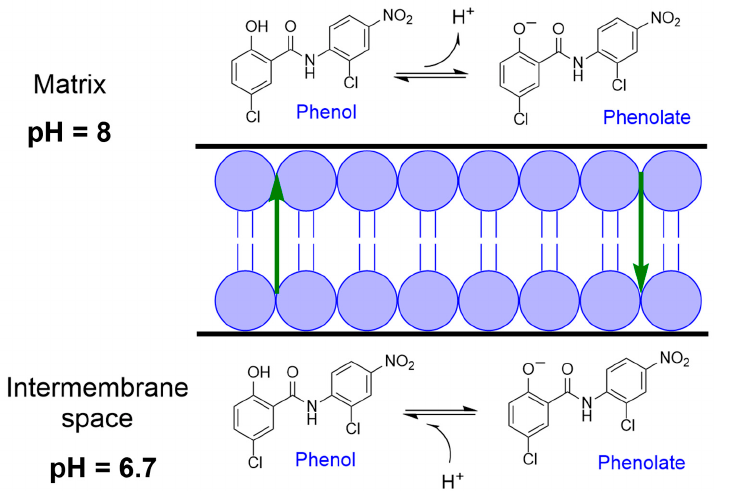
Figure 4. Protonophore activity of niclosamide in the inner mitochondrial membrane. Scheme was created according to